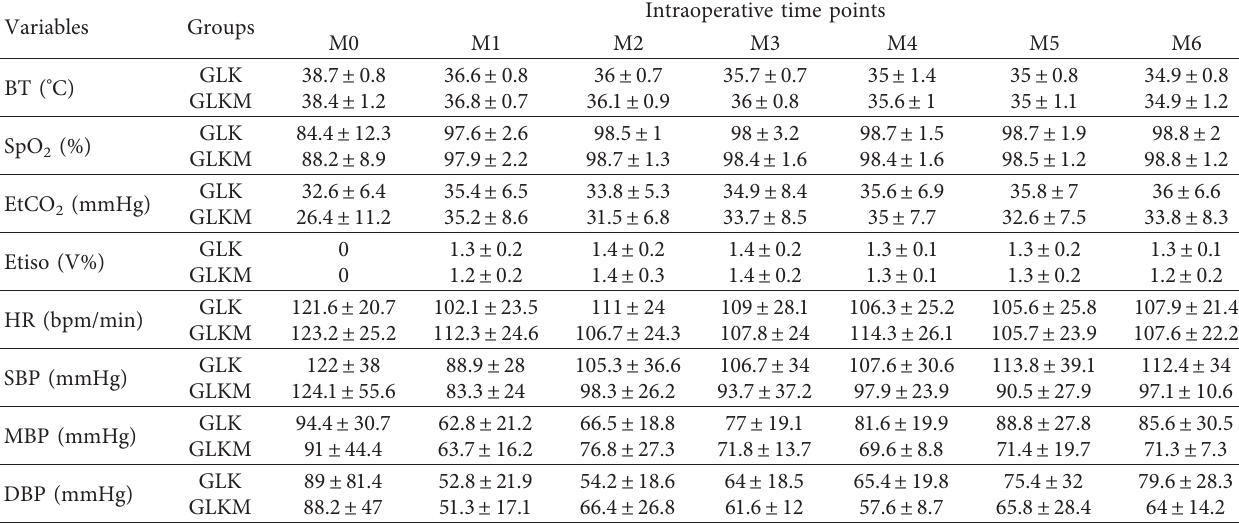
Table 1: Variables (means ± SD) of the physiological parameters recorded during the study. Variables Groups